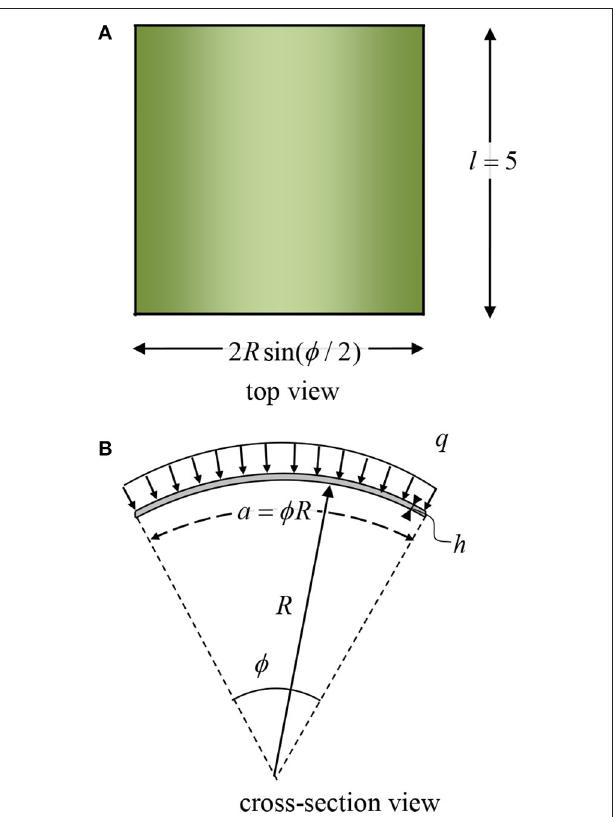
FIGURE 3 | The circular cylindrical shell and its geometry.